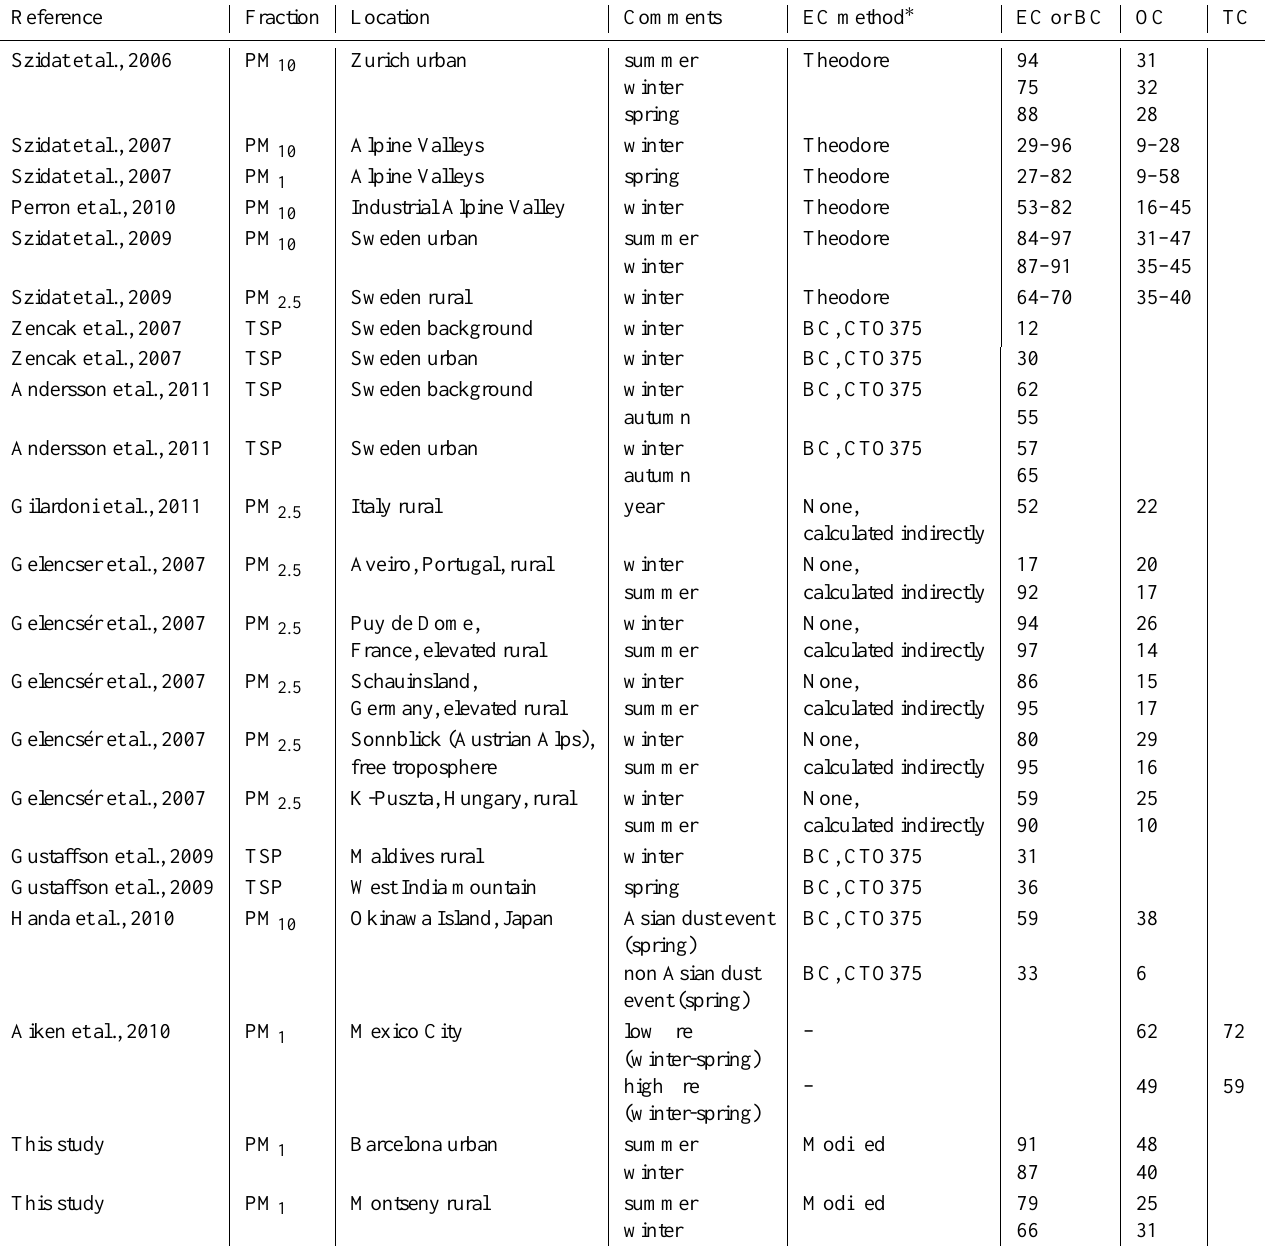
Table 1. Compilation of literature values of % fossil carbon in different fractions and sites and results from the present